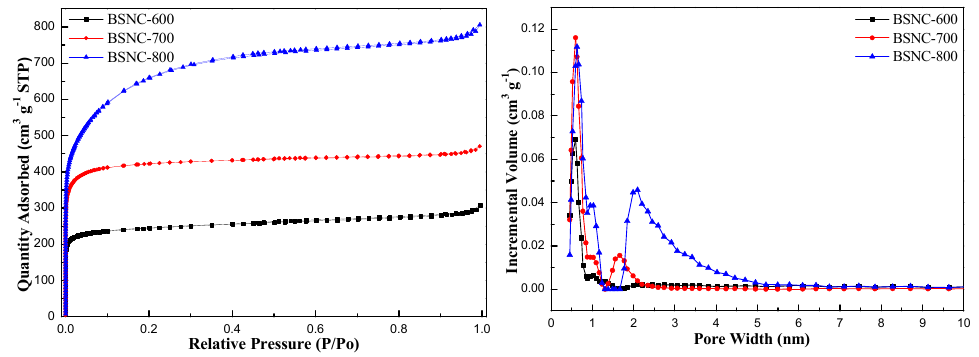
Figure 1. Nitrogen adsorption-desorption isotherm and pore size distribution.